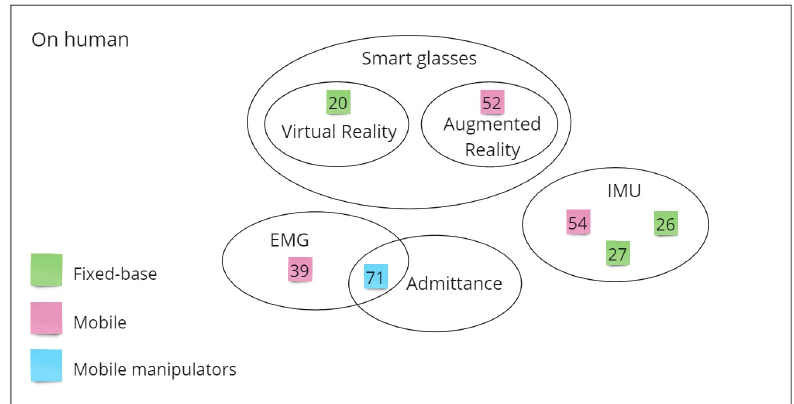
Figure 4. Most relevant sensors for HRP which can be found on the human operator. Table 1. Most relevant algorithms for HRP applications, grouped according to how the perception is implemented. Collision